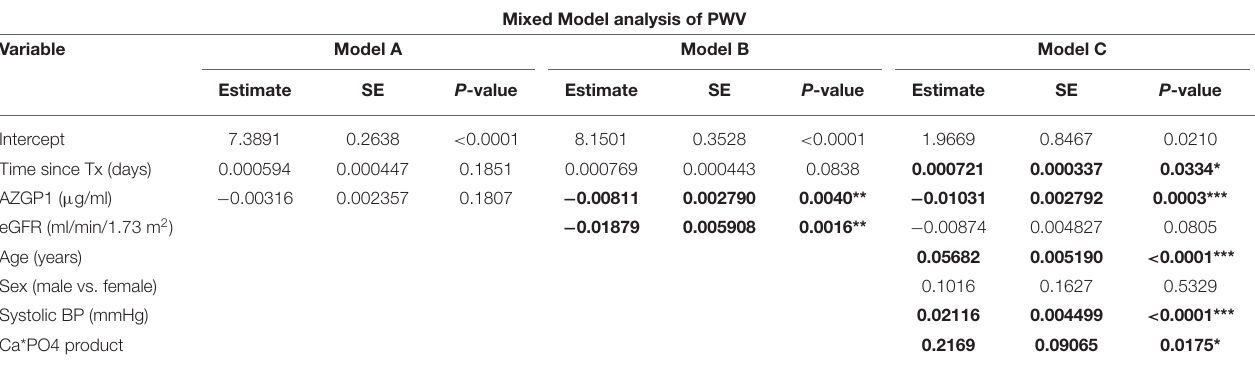
TABLE 3 | Longitudinal mixed model analysis of PWV and AZGP1 alone (Model A), AZGP1 together with eGFR (Model B) and AZGP1 together with eGFR, age, sex, blood pressure, and calcium-phosphorus product during the follow up of 2 years after